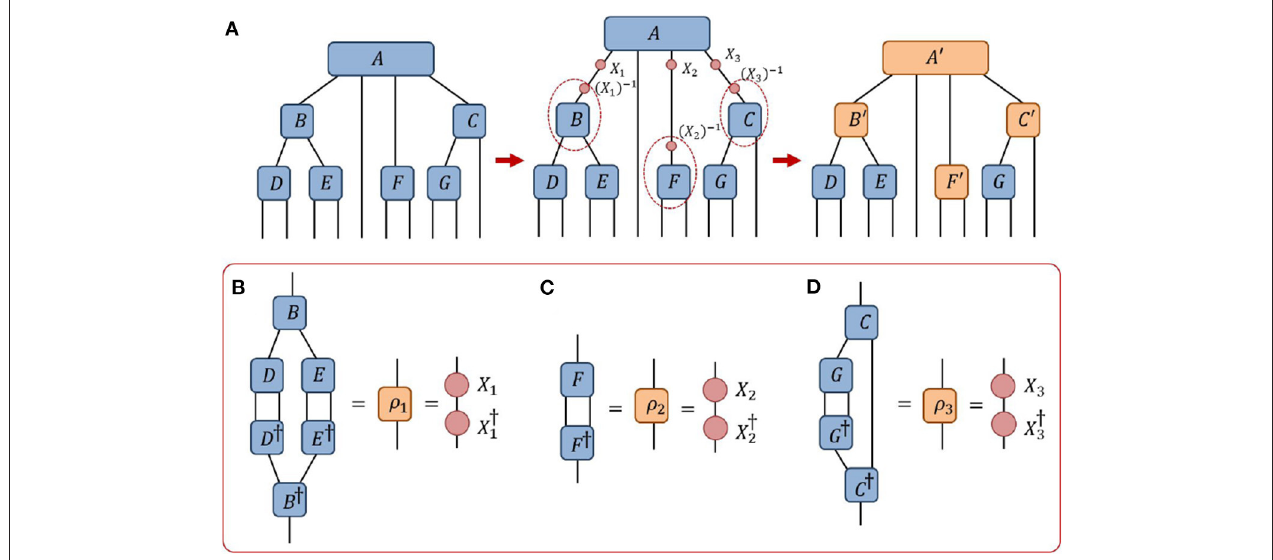
FIGURE 11 | A depiction of how the tensor A from the network of Figure 7 can be made into an orthogonality center via the “direct orthogonalization” approach. (A) A change of gauge is made on every (non-trivial) branch connected to A , such that A becomes an orthogonality center. (B–D) The gauge change matrices { X 1 , X 2 , X 3 } are obtained by contracting each branch with its Hermitian conjugate and then taking the principle root.